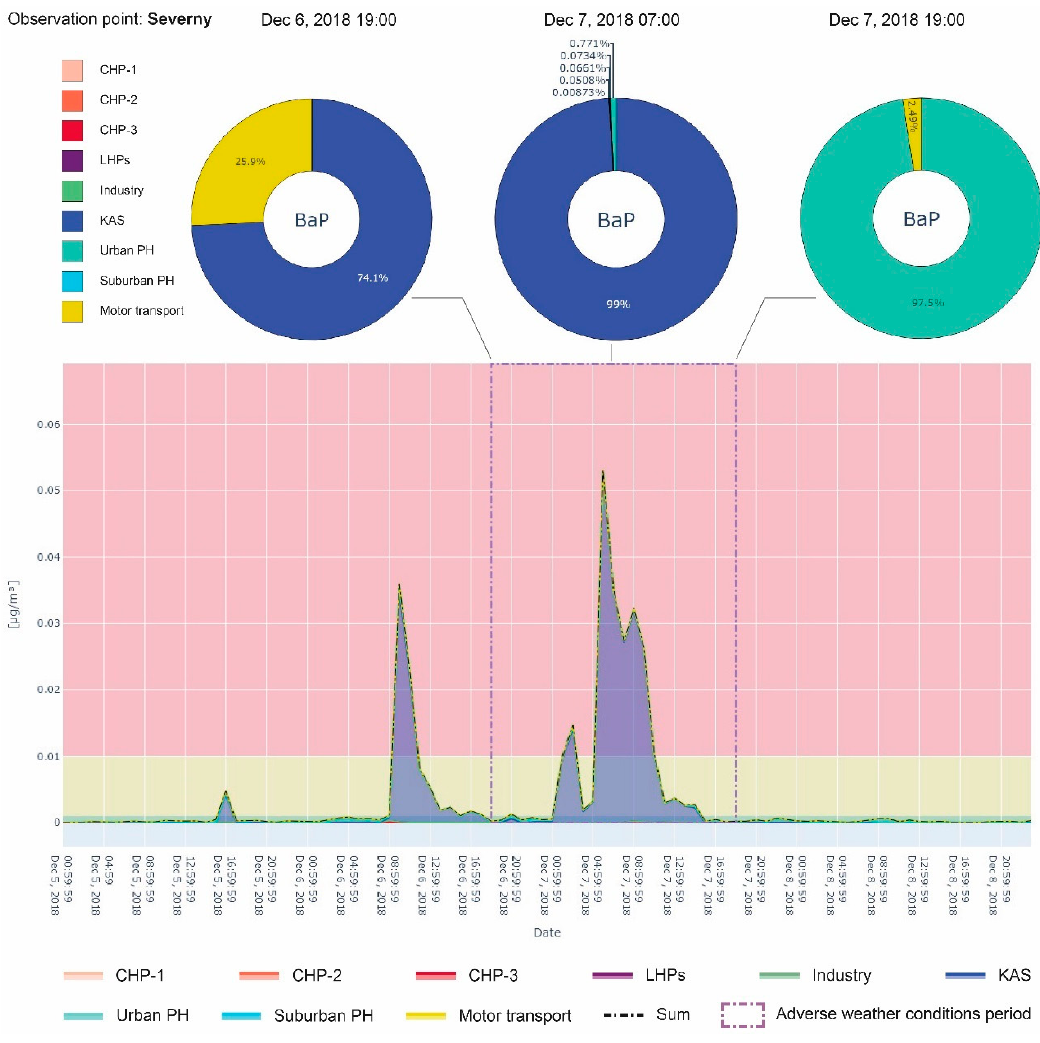
Figure 14. Simulated contributions of the main groups of emission sources in air pollution of BaP at 2 m height above the ground in the cells corresponding to the Severny observation point.